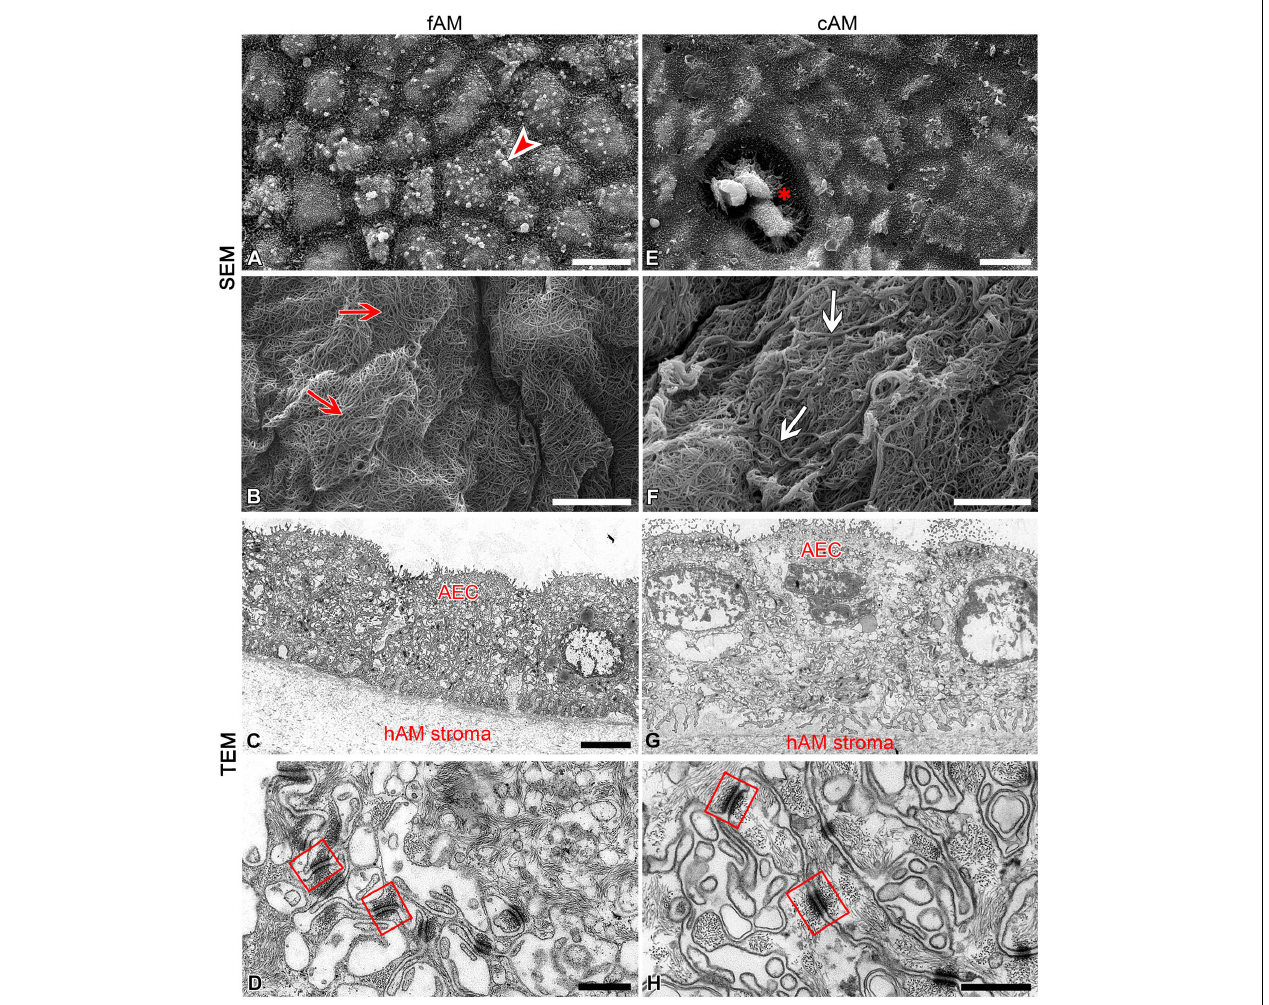
FIGURE 5 | Cryopreservation affects the ultrastructure of amniotic membrane. (A–D) Ultrastructure of fAM. Amniotic epithelial cells (AEC) are well-connected with surrounding cells and basal lamina (A,C,D) , and fibers of fAM stroma (B) were tightly interwoven (red arrows). (E–H) Ultrastructure of cAM. The apical surface is partly damaged, the remaining AEC are well-connected with surrounding cells and basal lamina (E,G,H) , and fibers of cAM stroma are forming thicker strands of fibers ( F ; white arrows). Bulbous forms on apical microvilli of amniotic epithelial cells of fAM (arrowhead), area of exposed basal lamina due to removal of AEC ( E ; asterisk), well-developed desmosomes (squares) connecting AEC. Three independent replications of experiments using three biological samples of fAM were conducted and five independent replications of experiments using five biological samples of cAM were performed. Scale bars: (A,E) 10 µ m; (B,C,F,G) 5 µ m; (D,H) 500 nm.